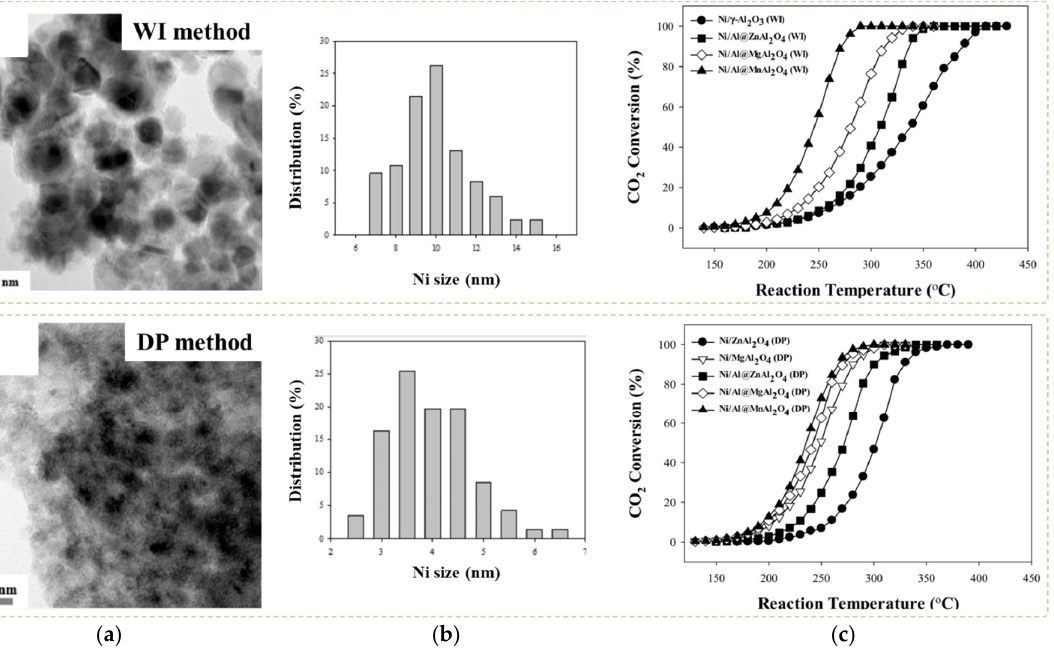
Figure 7. ( a ) HR-TEM image of Ni/Al@MnAl 2 O 4 (WI) and Ni/Al@MnAl 2 O 4 (DP), ( b ) Ni particle size distribution in Ni/Al@MnAl 2 O 4 (WI) and Ni/Al@MnAl 2 O 4 (DP), ( c ) catalytic performance of Ni/Al@MAl 2 O 4 prepared using the WI and DP methods for CO 2 methanation. All catalysts were reduced in H 2 at 500 °C. Reaction conditions: 1 mol% CO/CO 2 , 50 mol% H 2, 49 mol% He, F/W = 1000 mL/min g.cat. Retrieved with permission from Le et al. [84]; CO 2 Methanation over Ni/Al@MAl 2 O 4 (M = Zn, Mg, or Mn) Catalysts; copyright from MDPI, Catalysts, 2019.